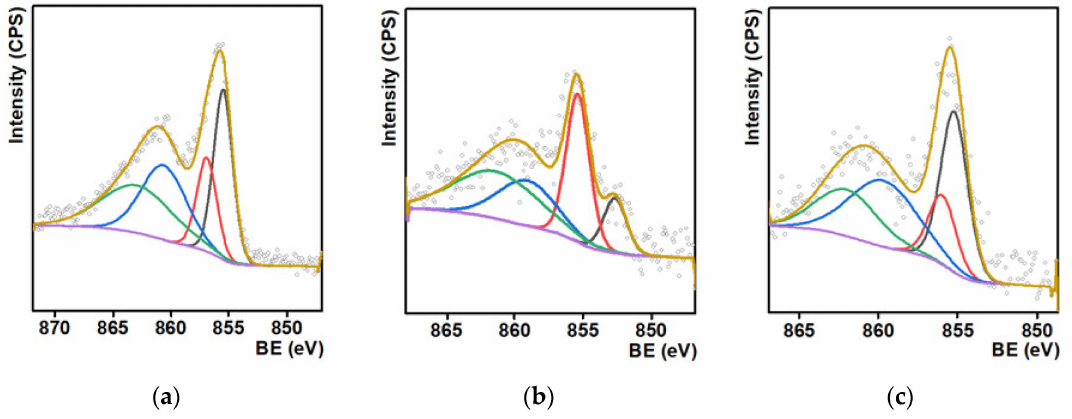
Figure 3. Ni 2p X-ray photoelectron spectra of the Ni/C-3 composite ( a ), and the same sample after the catalytic experiments on the hydrogenation of quinoline (T = 100 ◦ C, p(H 2 ) = 100 atm, 24 h, methanol) ( b ) and after six cycles of the same catalytic experiments ( c